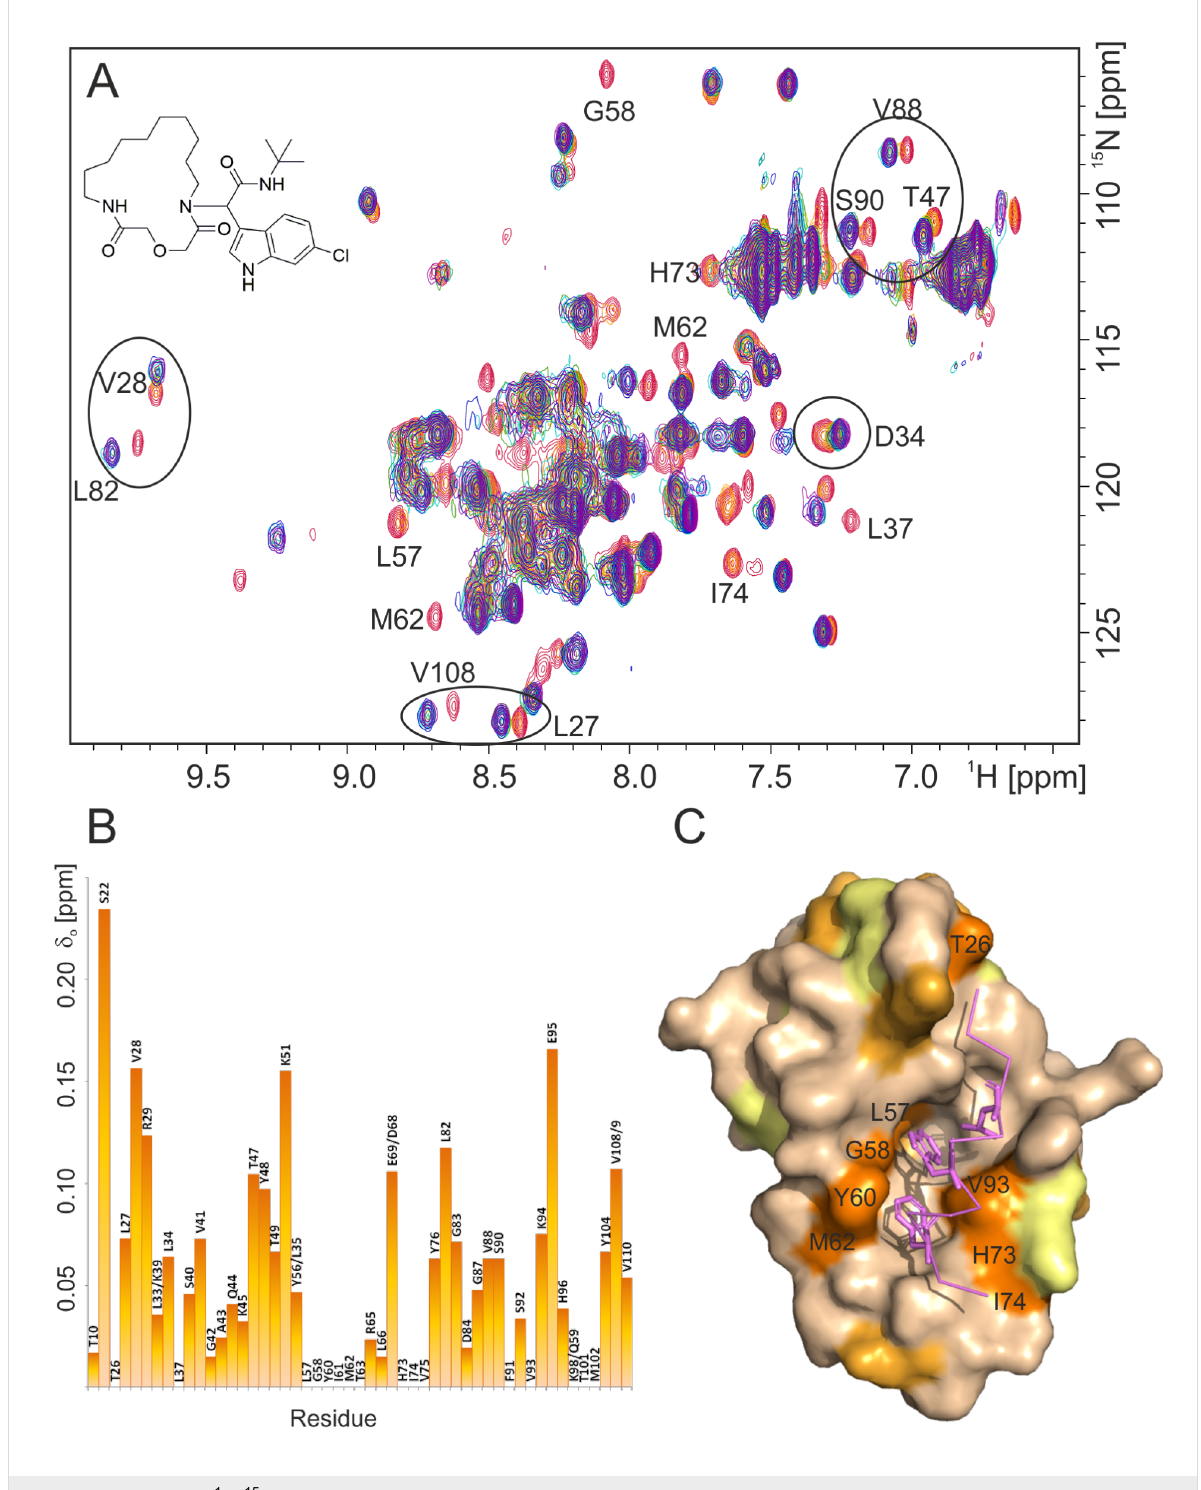
Figure 2: (A) Overlay of 1 H, 15 N-HSQC spectra of the reference MDM2 (red) and the titration steps with the 2i inhibitor. MDM2/ 2i ratios 4:1 (orange), 4:2 (yellow), 4:3 (green), 1:1 (light blue), 1:2 (blue), 1:5 (purple). Examples of most perturbed residues are labeled on the spectrum. (B) Normalized chemical shift perturbations ( δ o ) of MDM2 residue (calculated according to Stoll et al. [41]). Residue with δ o equal 0 are either despairing from MDM2 spectrum upon titration or cannot be identified. (C) Chemical shift perturbations plotted onto the structure of MDM2 (wheat); orange (despairing – indi- cating stronger binding), light orange (>0.1 ppm), yellow (0.05–0.1 ppm). Residues which disappear upon titration experiment are labeled on the Mdm2